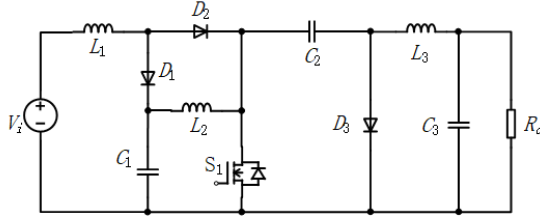
Figure 24. A hybrid cascaded DC-DC converter.